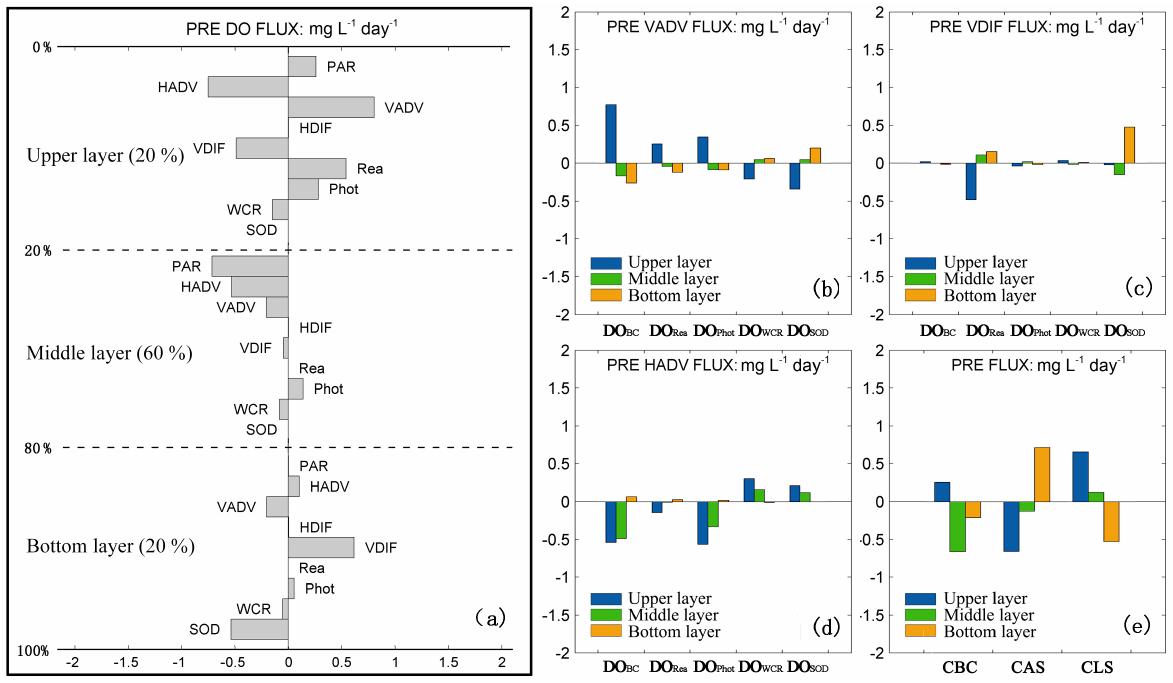
Figure 11. (a) The simulated DO mass balance (averaged over July–August 2006) for the PRE. All the diagnostic terms are given for the upper layer above the 20% of depth, for the middle layer, and for the bottom layer, which covers 20% of depth over the sediment. Contributions of each source and sink process as well as boundary conditions to (b) the vertical advective DO fluxes, (c) the vertical diffusive DO fluxes, and (d) the horizontal advective DO fluxes. (e) Contributions of boundary conditions (CBC), adjacent source and sink terms (CAS), and local source and sink terms (CLS) to the DO balance. Abbreviation PAR represents localized partial derivatives of DO; SOD and DO SOD represent the sediment oxygen demand and the changes of DO concentrations due to the effects of sediment oxygen demand, respectively; WCR and DO WCR represent the water column respiration and the changes of DO concentrations due to the effects of water column respiration, respectively; Phot and DO Phot represent the photosynthesis and the changes of DO concentrations due to the effects of photosynthesis, respectively; Rea and DO Rea represent the re-aeration and the changes of DO concentrations due to the effects of re-aeration, respectively; DO BC represents the changes of DO concentrations due to the effects of boundary conditions; VADV represents the vertical advection of DO; HADV represents the horizontal advection of DO; VDIFF represents the vertical diffusion of DO; and HDIFF represents the horizontal diffusion of